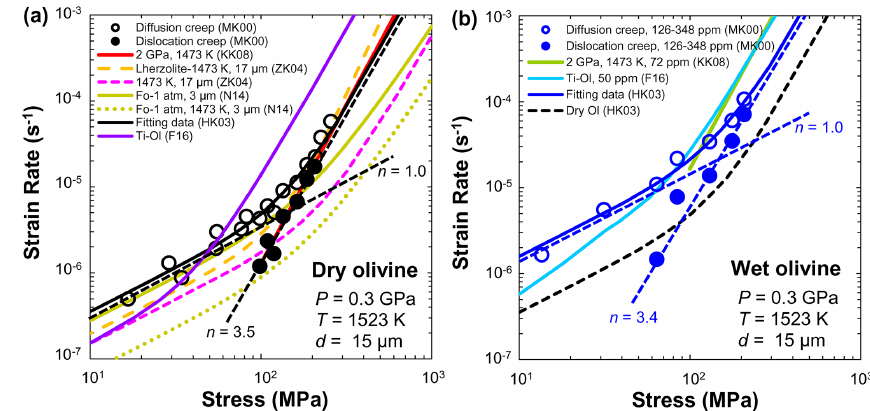
Figure 13. Compilation of flow laws (strain rate versus differential stress) for fine-grained olivine aggregates deformed under dry (a) and hydrous (b) conditions. Data sources: MK00 (Mei and Kohlstedt, 2000a, b); HK03 (Hirth and Kohlstedt, 2003); KK08 (Katayama